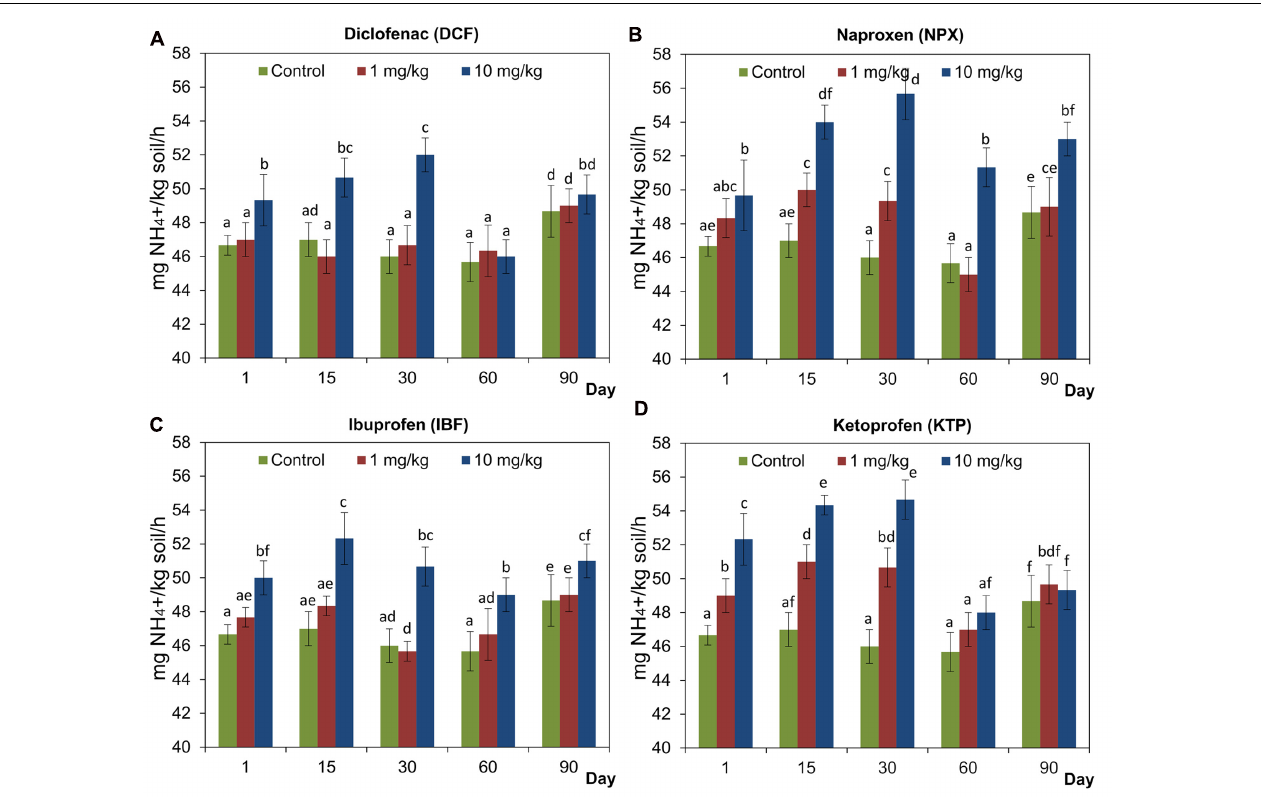
FIGURE 6 | Urease (URE) activity in control soil and soil treated with diclofenac (A) , naproxen (B) , ibuprofen (C) , and ketoprofen (D) at concentrations of 1 and 10 mg/kg soil during the 90-day experiment. The data presented are the means and standard deviations of three replicates and are expressed as mg NH 4 + /kg soil/h. Different letters (within each drug) indicate significant differences ( P < 0.005, LSD test) related to the effects of concentration and time.